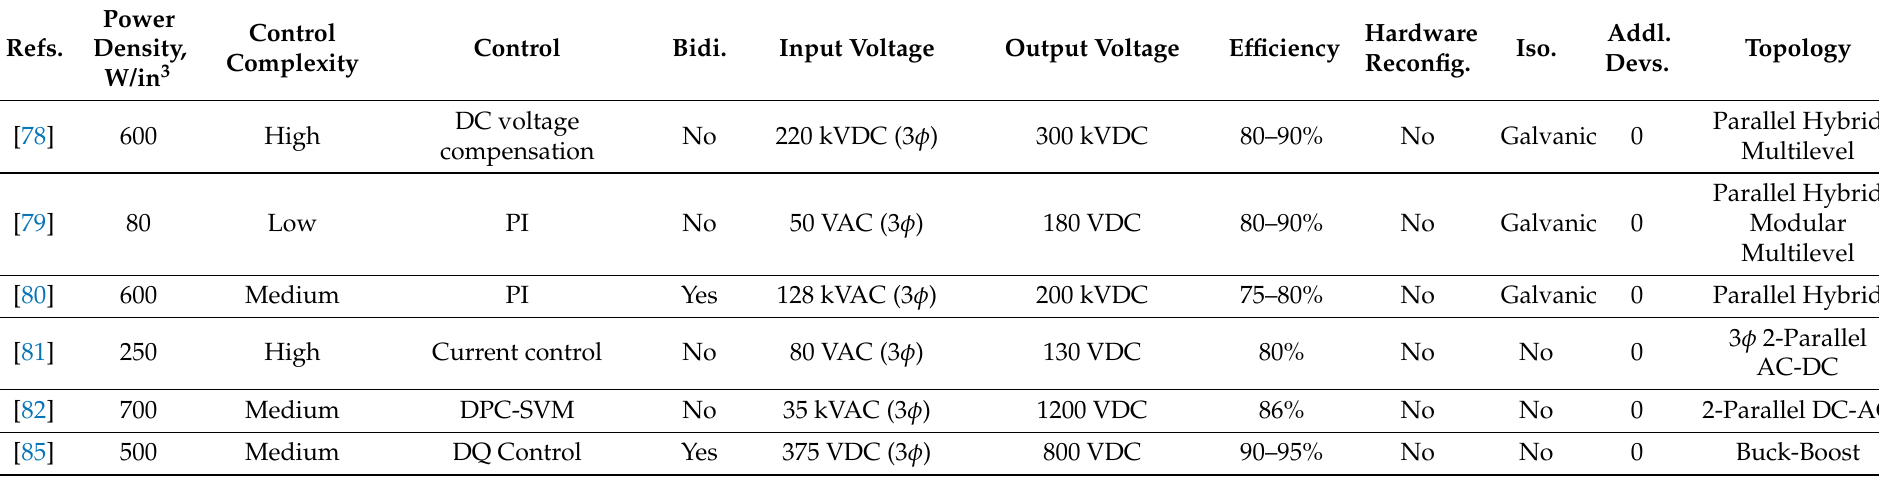
Table 4. Comparison of the different fault-tolerant system level techniques.